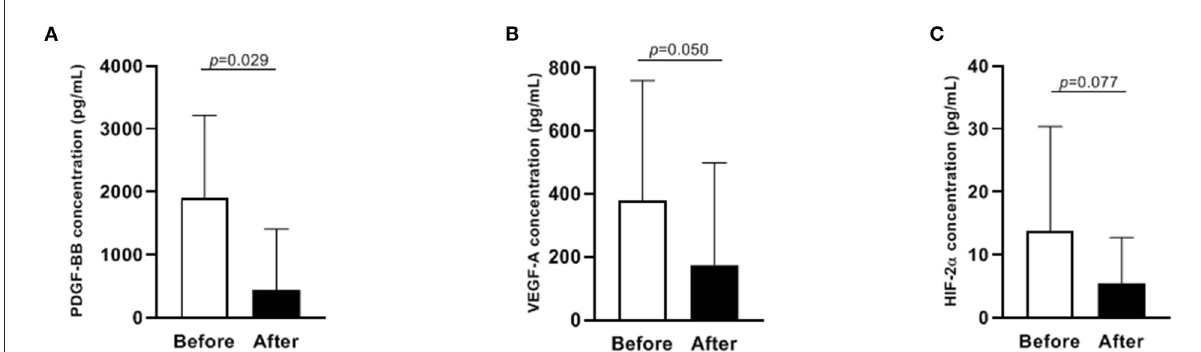
FIGURE2 Levels of PDGF-BB, VEGF-A and HIF-2 α before and after ibuprofen treatment in 17 infants (A–C) . Data were presented as median with IQR. PDGF-BB, platelet-derived growth factor BB; VEGF-A, vascular endothelial growth factor A; HIF-2 α , hypoxia-inducible factor 2 α . Only 12 paired data were shown in (C) because the concentration of HIF-2 α was below the detection limit in the rest samples.